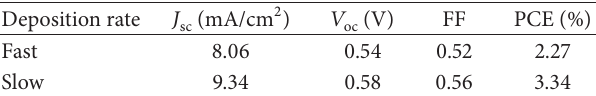
Figure 7: J-V characteristics of the devices with different deposition rates. Table 5: Photovoltaic parameters of the devices with different deposition rate, measured under 100mW/cm 2 illumination (AM